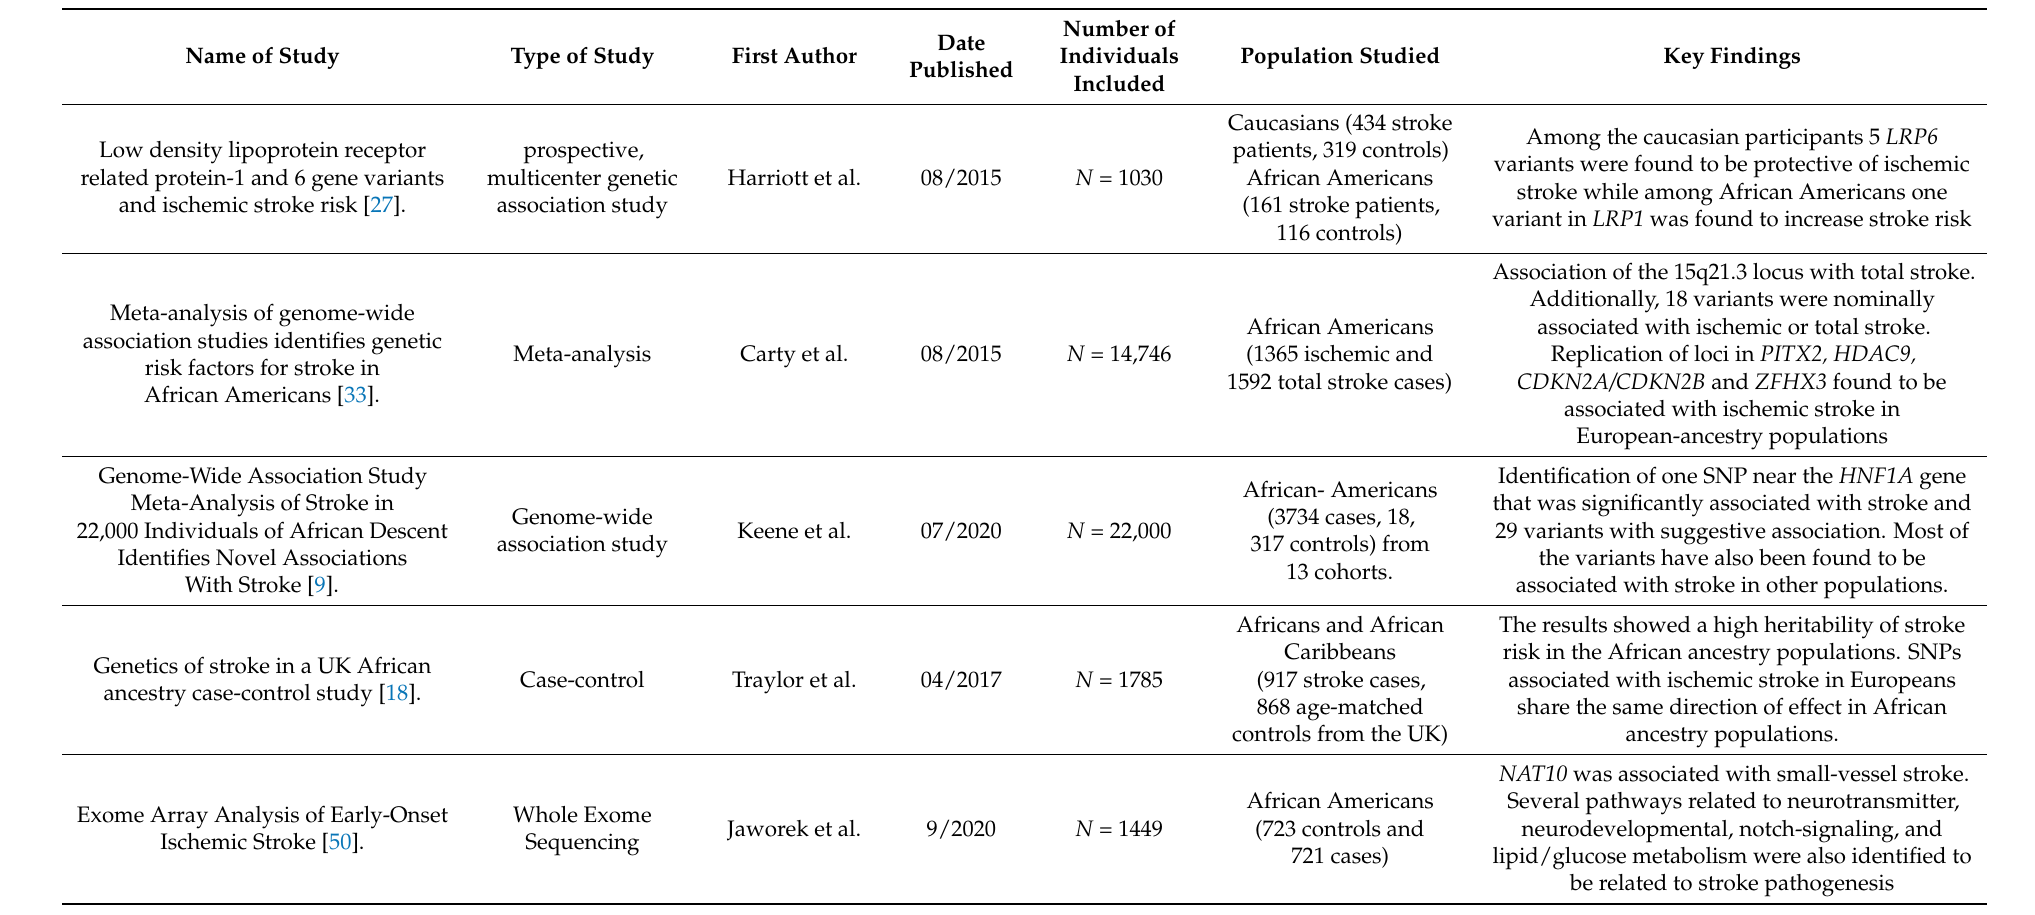
Table 2. Genetic Stroke studies including individuals of African